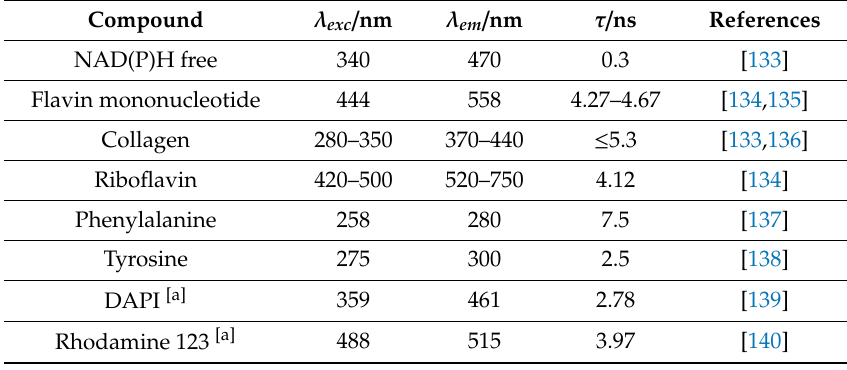
Table 2. Excitation ( λ exc ) and emission ( λ em ) wavelengths peaks, and emission lifetimes ( τ ) for some of the cell components and dyes used in cellular luminescence imaging